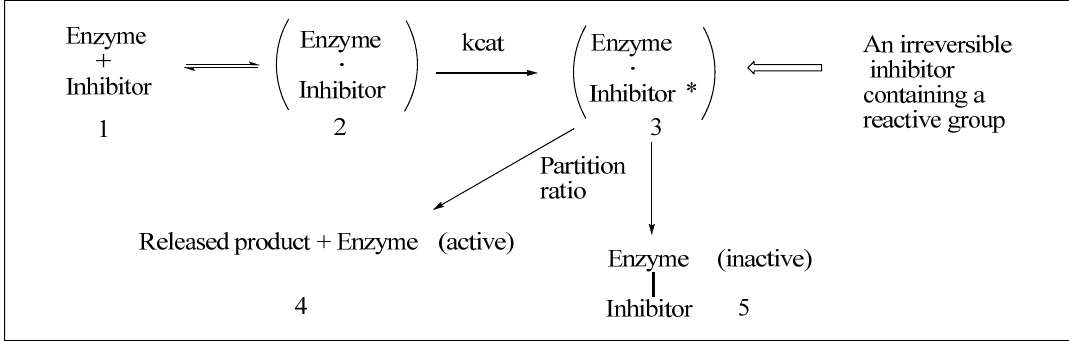
Figure 6. Process for mechanism-based enzyme inactivation 1 to 3 to 5 .